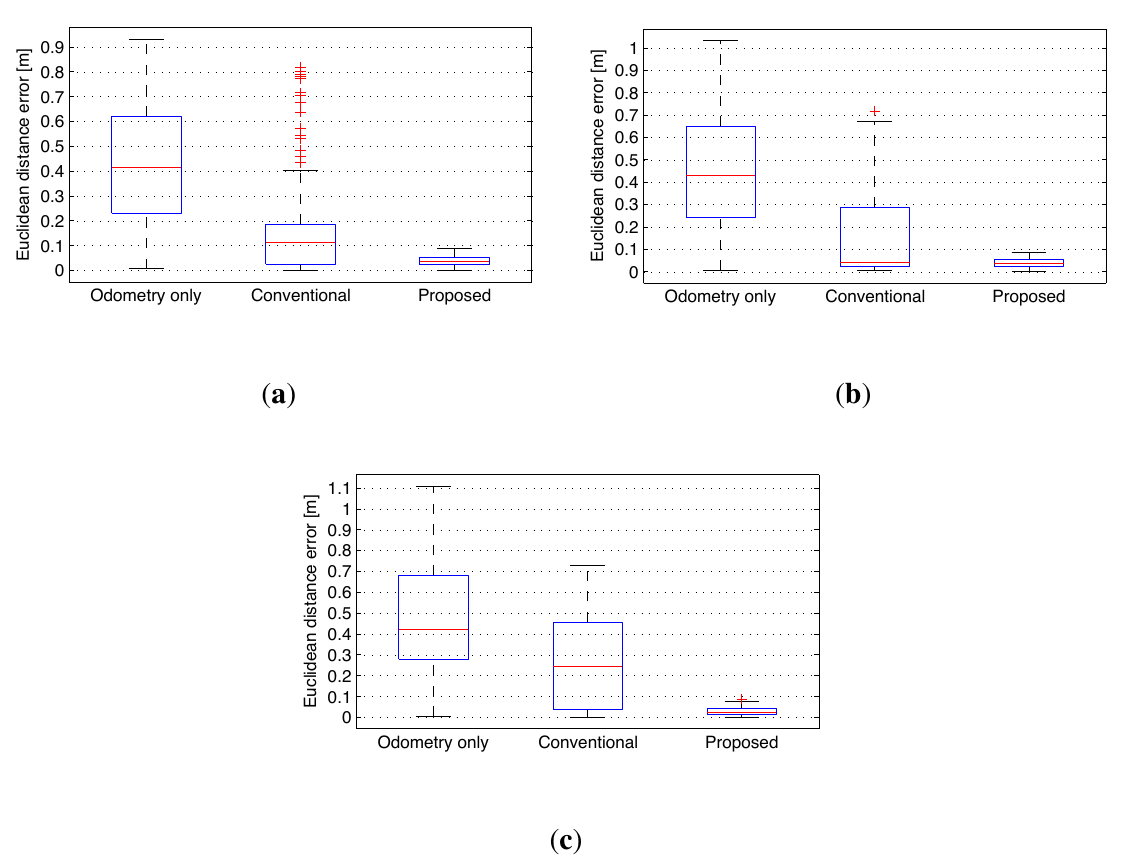
Figure 26. Euclidean distance errors relative to the ground truth data. ( a ) Experiment 1; ( b ) Experiment 2; ( c ) Experiment